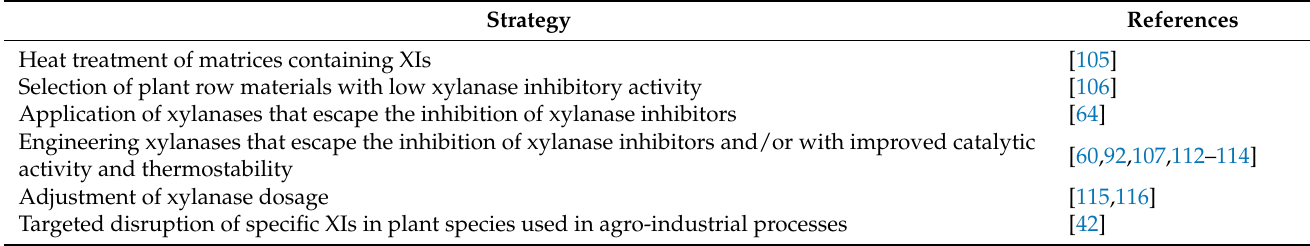
Table 2. Strategies to reduce the negative effects of XIs in agro-industrial processes.